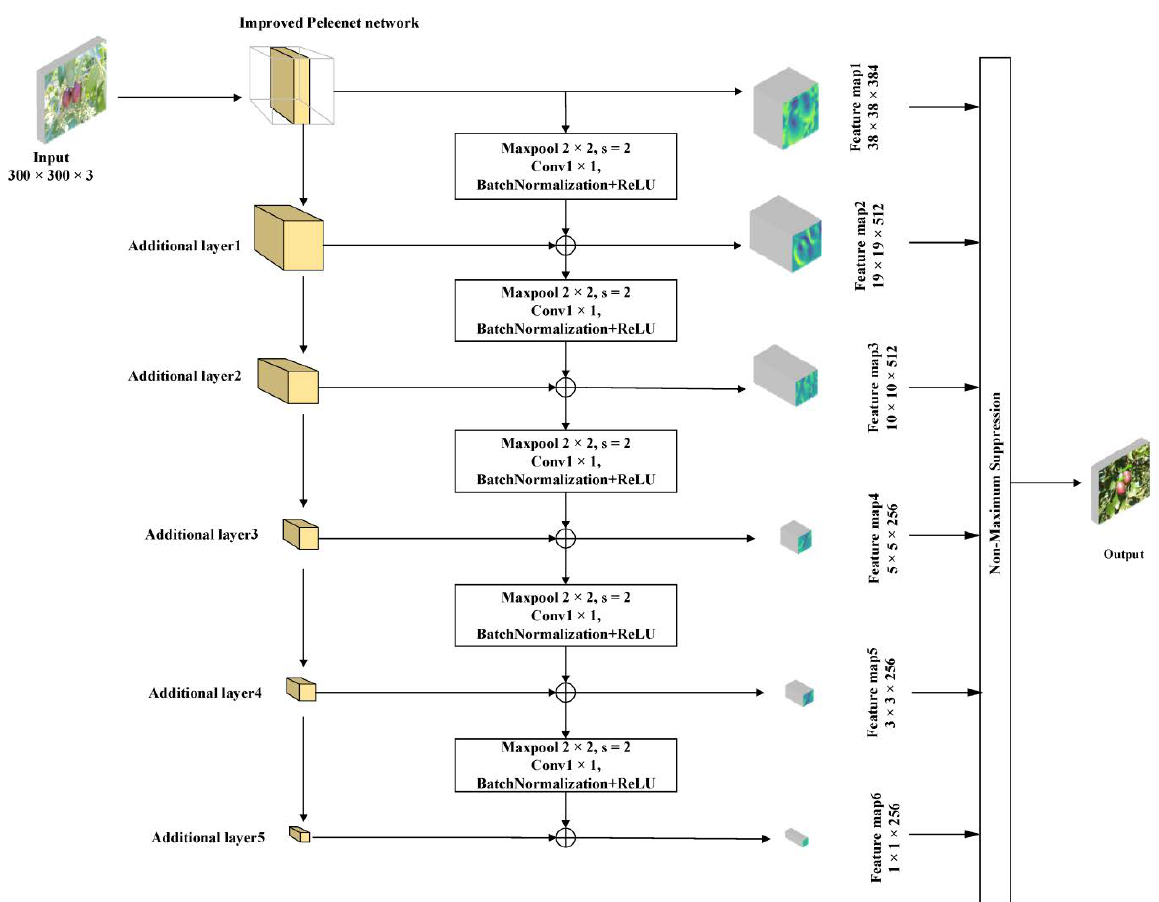
Figure 7. The improved SSD target detection model structure.